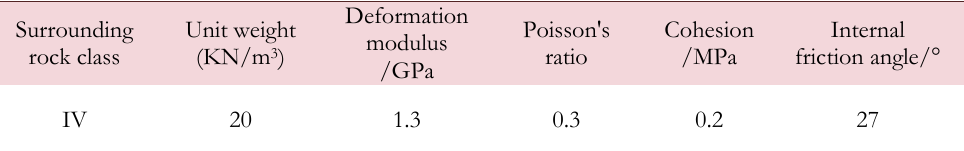
Table 8: Physical and mechanical parameters of surrounding